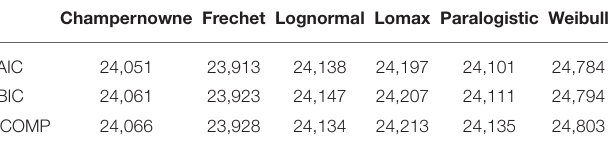
TABLE 9 | Simulation: Information criteria for Champernowne, Frechet, Lognormal, Lomax, Paralogistic, and Weibull models. Champernowne Frechet Lognormal Lomax Paralogistic Weibull